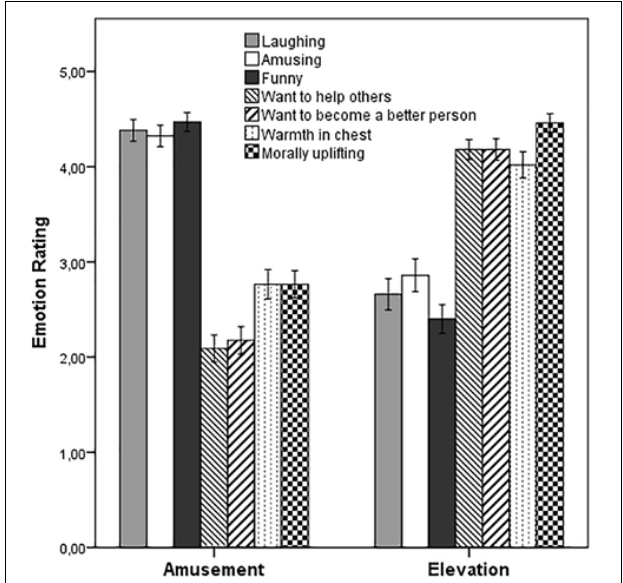
FIGURE 1 | Mean self-reported feelings and appraisals from participants as a function of video condition. Error bars indicate standard errors. The results depicted are those using the trimmed sample, N =